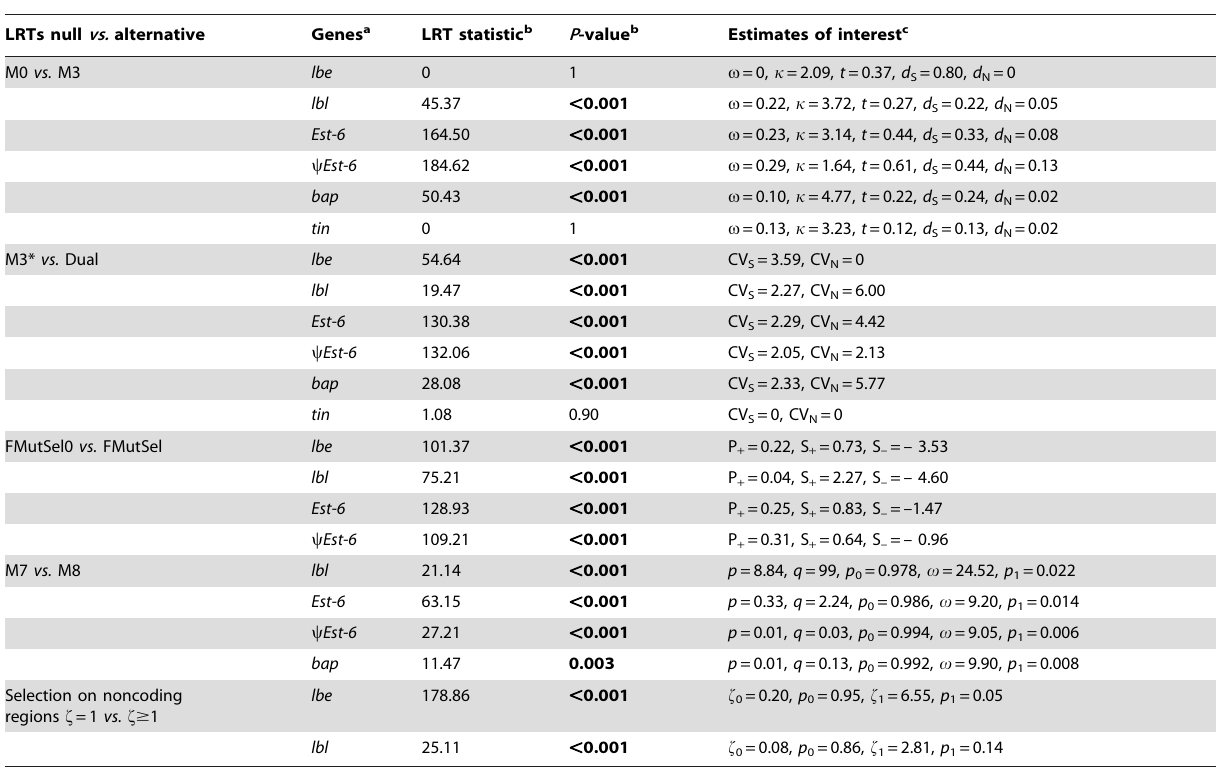
Table 3. Likelihood ratio tests LRTs based on codon models of evolution.